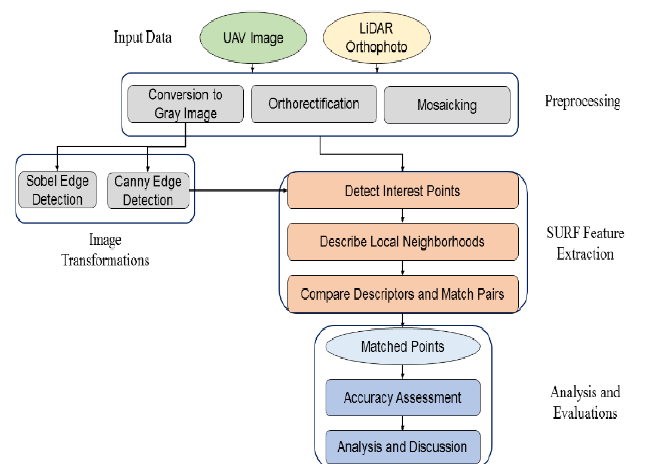
Figure 2. Overall workflow of this